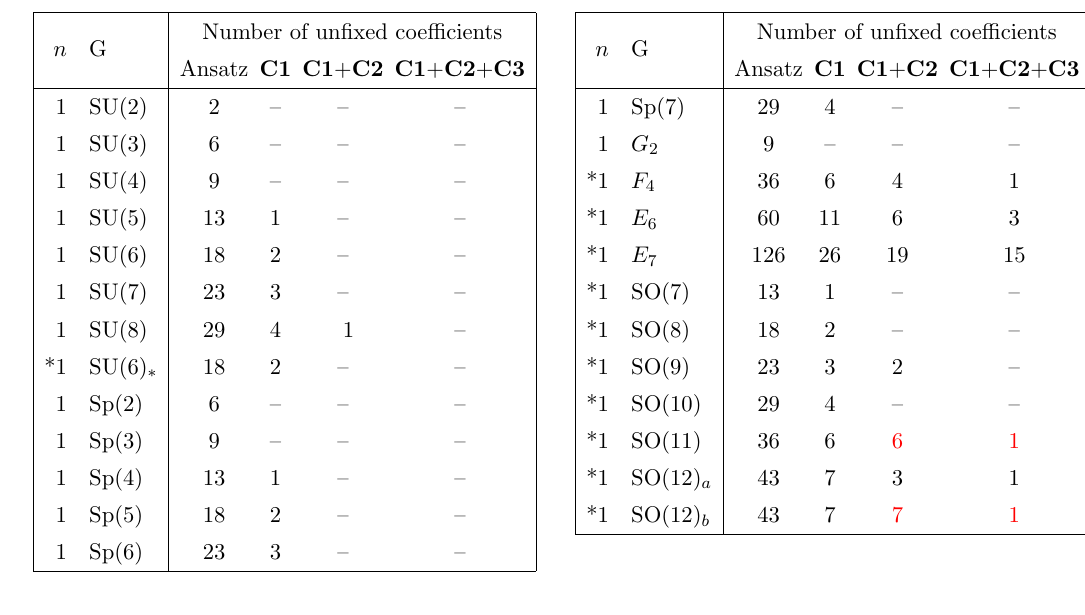
Table 24. Fixing the Ansatz for n = 1. For each theory, we list the total number of un(cid:12)xed coe(cid:14)cients in the Ansatz, and in the remaining columns the number of coe(cid:14)cients left un(cid:12)xed after imposing successively the constraints C1 , C2 , and C3 . For the h SO(11)